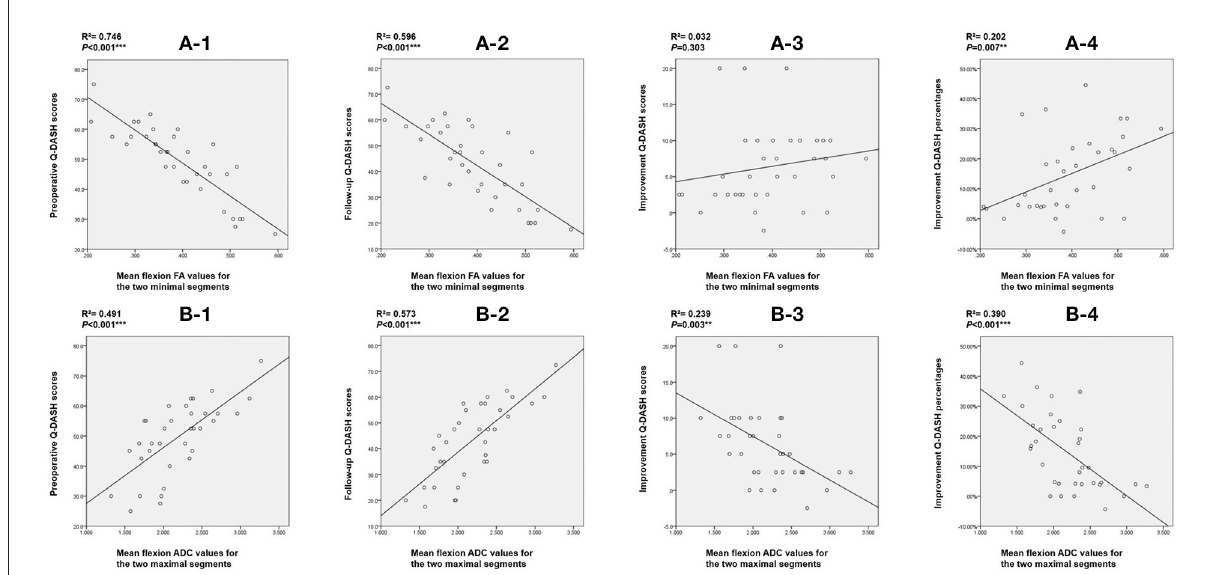
FIGURE6 Correlation between DTI indices and Q-DASH scores. (A) Correlation between mean flexion FA value for the two minimal segments and (1) preoperative Q-DASH score; (2) final follow-up Q-DASH score; (3) improvement Q-DASH score; (4) improvement Q-DASH percentage. (B) Correlation between mean flexion ADC value for the two maximal segments and (1) preoperative Q-DASH score; (2) final follow-up Q-DASH score; (3) improvement Q-DASH score, and (4) improvement Q-DASH percentage. DTI, diffusion tensor imaging; Q-DASH, quick- disabilities of the arm, shoulder and hand; FA, fractional anisotropy; ADC, apparent diffusion